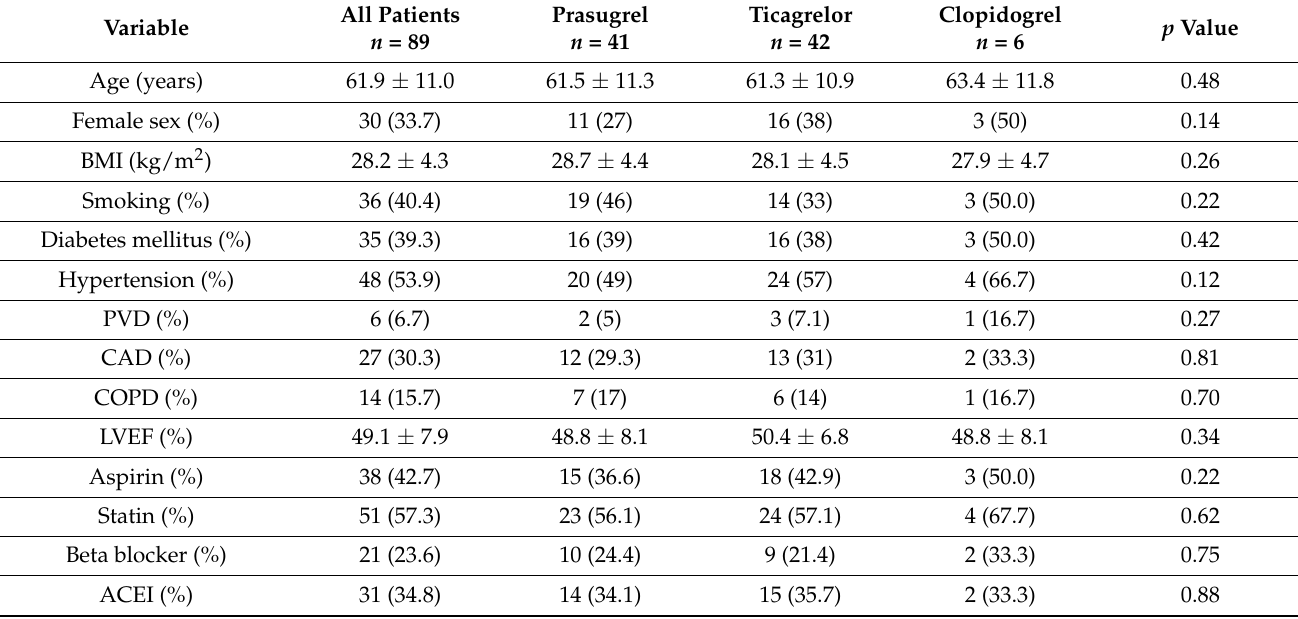
Table 1. Baseline characteristics of the cohort.